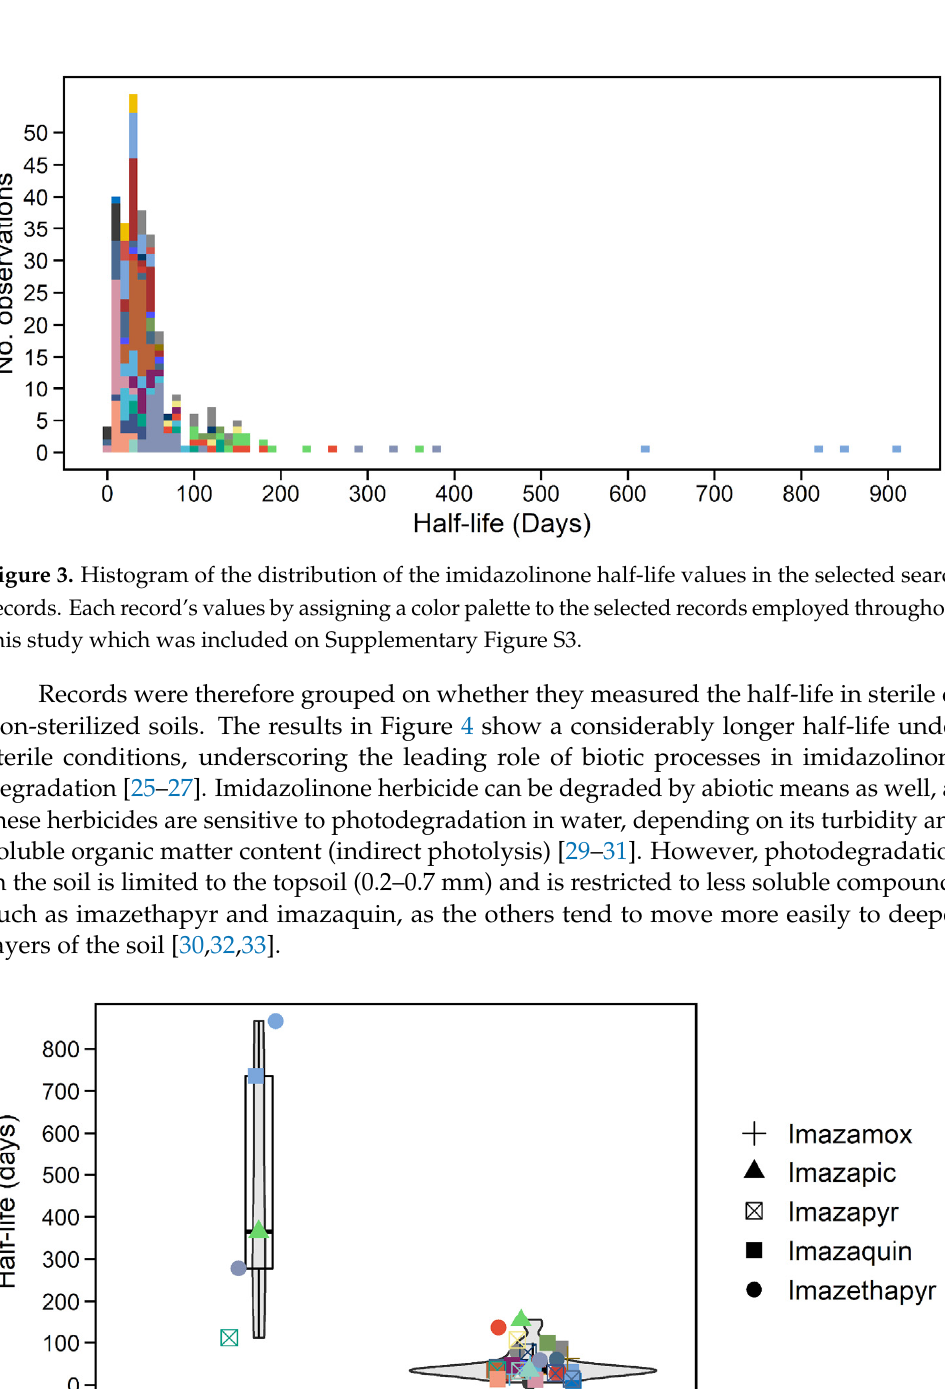
Figure 4. Half-life of imidazolinones in sterile and unsterilized soil.